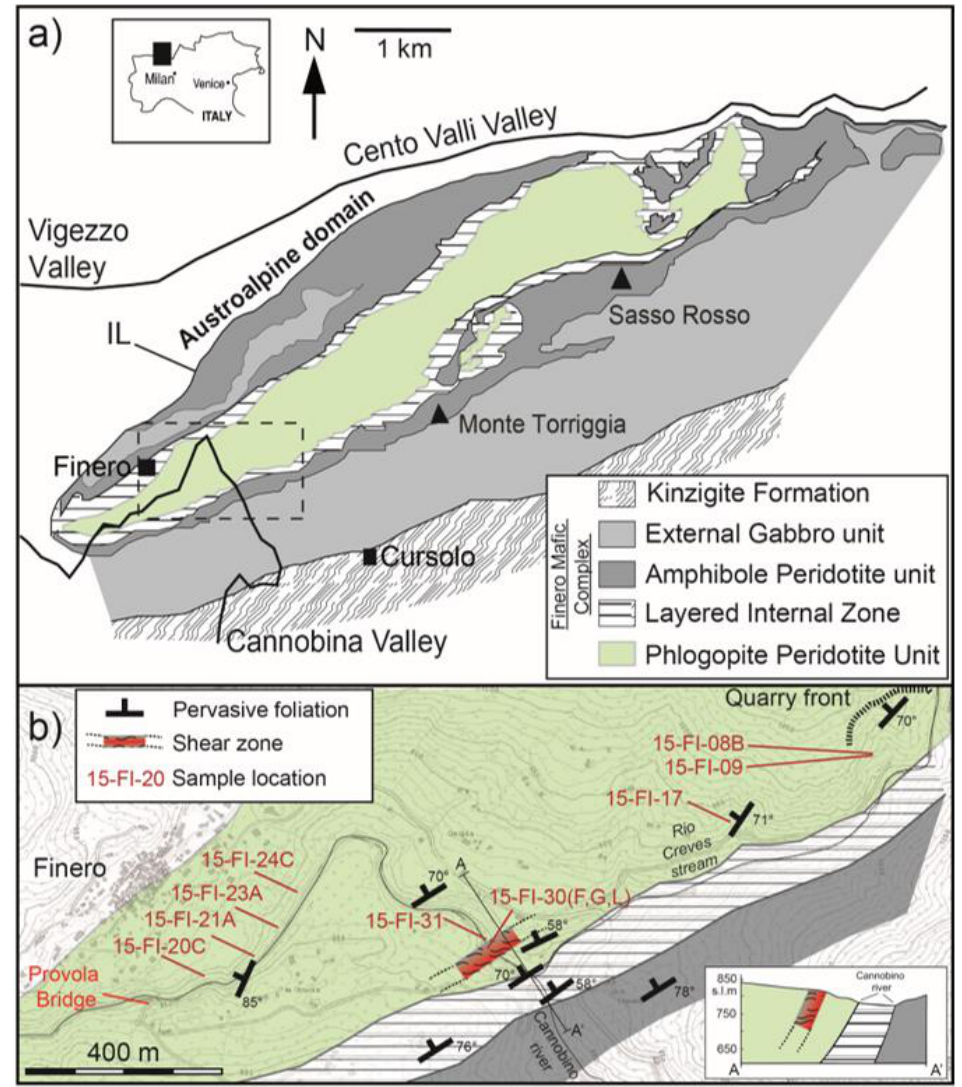
Figure 1. ( a ) Geological map of the northern sector of the Ivrea-Verbano zone showing the main units of the Finero Complex, as well as the Insubric Line (IL) and the Kinzigite Formation, which bounds it to the NW and SE, respectively. ( b ) Sketch map of the area east/northeast of Finero village showing representative attitudes of pervasive foliation and location of samples used for petrography, microstructures, and chemistry (red labels; modified after Tommasi et al. [16]). The studied shear zone is also shown as well as a schematic geological cross section (bottom right).